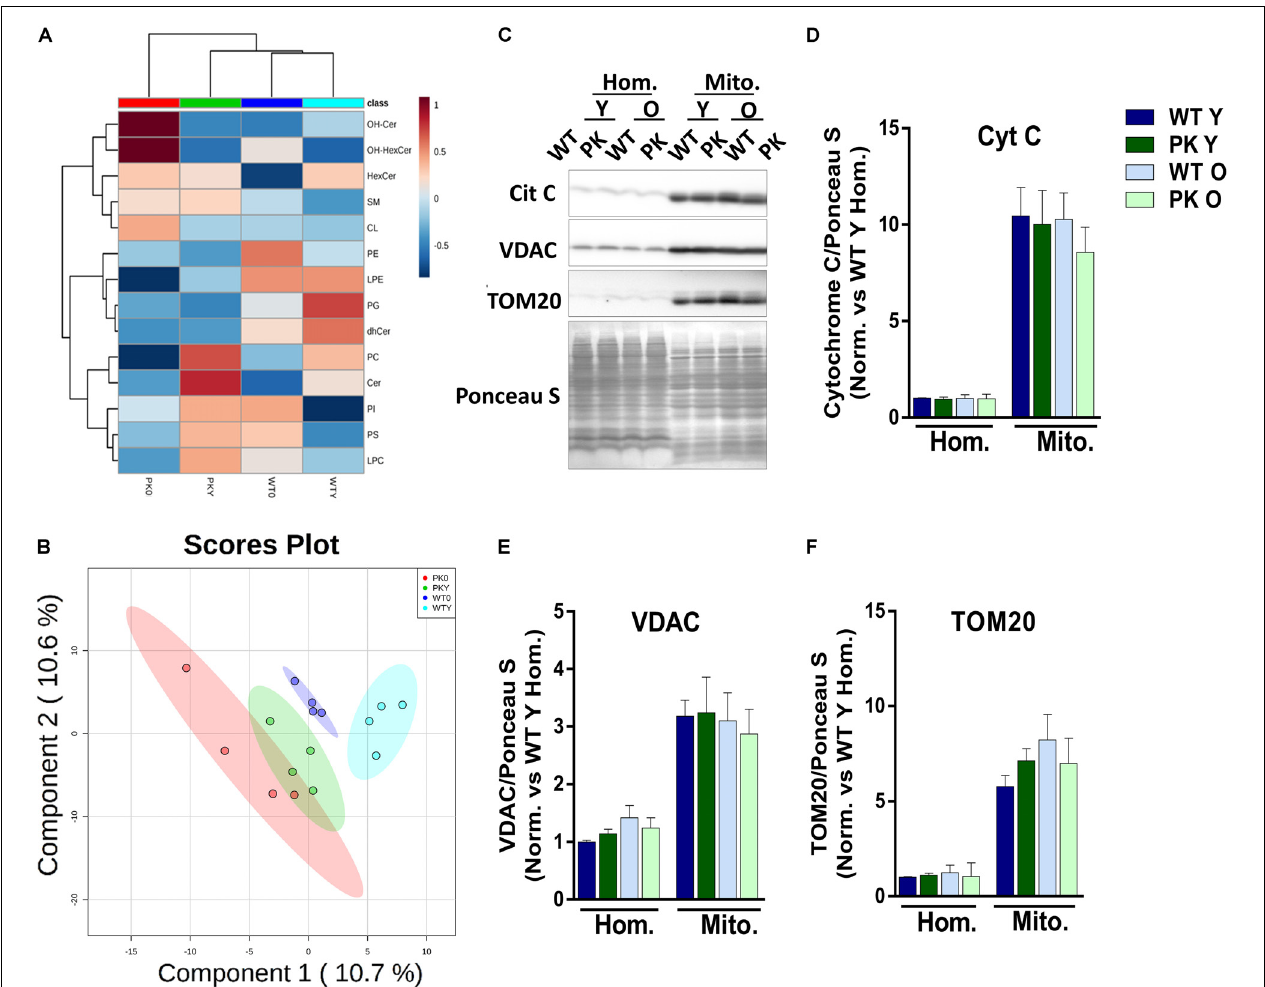
FIGURE 1 | Lipidomic composition of brain’s mice mitochondria change due to aging and parkin loss. Lipidomic analysis and enrichment of mitochondrial fraction isolated from WT and PK-KO mice’s brain. (A) Heatmap of lipidomic classes detected and changes due to aging and parkin loss expressing the relative differences between the groups after normalization and the hierarchical clustering. (B) 2D representation of the Partial Least Square Discriminant Analysis of brain’s mitochondrial lipidomic composition. (C) Western-Blot experiments showing homogenates and mitochondria stained for Cytochrome C, VDAC, and TOM20. (D) Quantification of Cyt C signal intensity in homogenates and mitochondria. (E) Quantification of VDAC signal intensity in homogenates and mitochondria. (F) Quantification of TOM20 signal intensity in homogenates and mitochondria. n = 4–6 for western blot analysis. Graphs represent the mean ± SEM. Panels A,B were made using MetaboAnalyst software. Statistical analysis of western blot experiments was done by One Way ANOVA test. OH Cer, hydroxylated ceramide; OH HexCer, hydroxylated hexosylceramide; HexCer, hexosylceramide; SM, sphingomyelin; CL, cardiolipin; PE, phosphatidylethanolamine; LPE, lysophosphatidylethanolamine; PG, phosphatidylglycerol; dhCer, dihydroceramide; PC, phosphatidylcholine; Cer, ceramide; PI, phosphatiylinositol; PS, phosphatidylserine; LPC, lysphosphatidylcholine; Hom, homogenate; Mito, mitochondria; Cyt C, cytochrome C; Y, young; O,